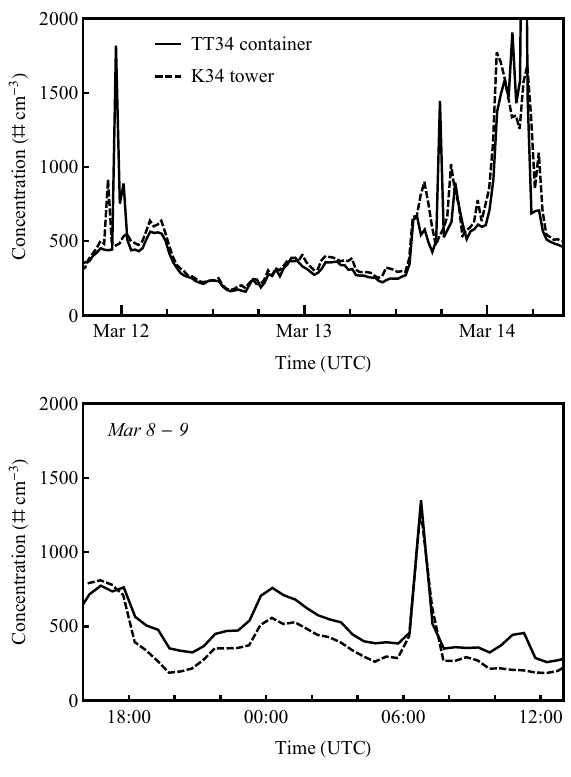
Fig. 2. Particle number concentrations recorded inside the container at the bottom of tower TT34 and contemporaneously at the top of tower K34, which was located 1.6 km from TT34. (The excursions above 500 cm − 3 represented as abrupt spikes are tagged as pollution events in Fig. S4. These spikes are believed to arise when the omnipresent regional plume from Manaus, which is generally westward, veers to the north and intersects the AMAZE-08 site. The similar magnitude of the spikes at TT34 and K34 supports that the inlet and sampling on both towers did not introduce bias into the measurements of the total particle number concentration.)